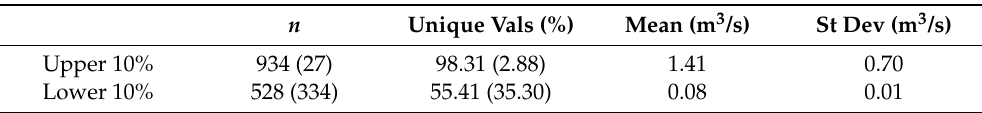
Table 5. Comparison of the upper (90th percentile) and lower (10th percentile) tails of the average probability density functions for the NWM retrospective stream segments used in the study. Numbers in parenthesis represent standard deviation of the respective values, while all other values represent the average across all segments. Note that the different value of n for the upper and lower 10% is a result of filtering values of 0 m 3 /s from the analyzed time